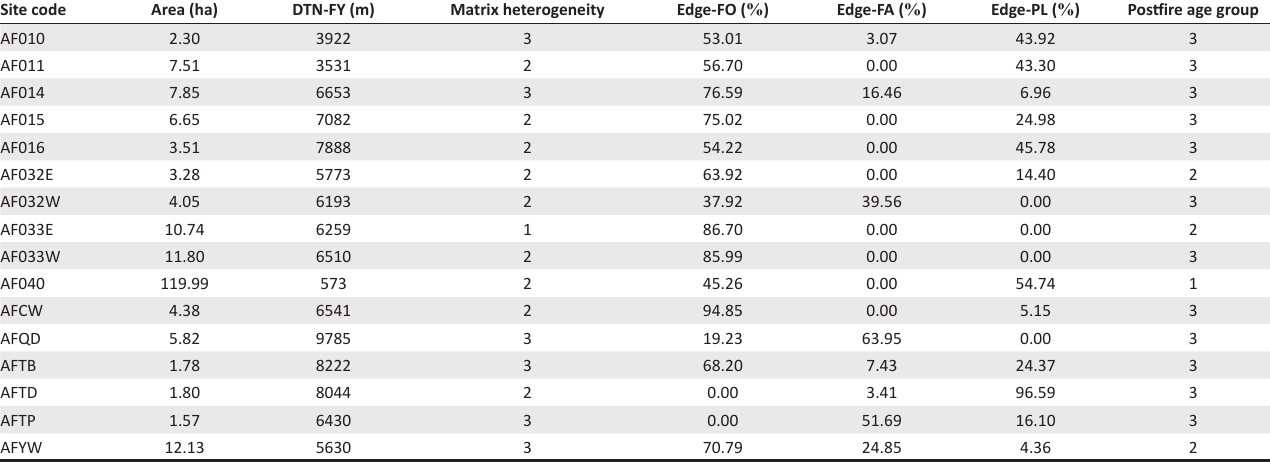
TABLE 1-A2: Physical characteristics of the artificial fragments included in the